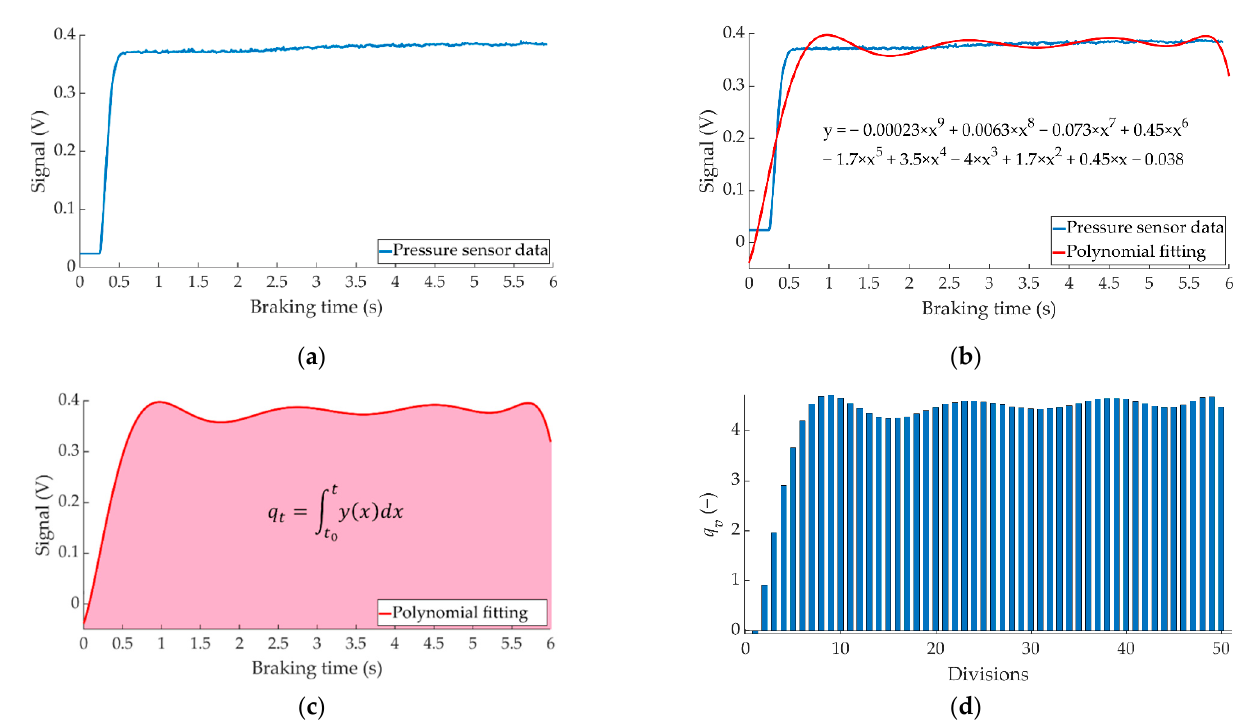
Figure 9. Methodology for the analysis of the data acquired by the pressure sensors to obtain the indicators. ( a ) raw sensor measurement, ( b ) fitted function, ( c ) q t and ( d ) q v for 50 divisions.